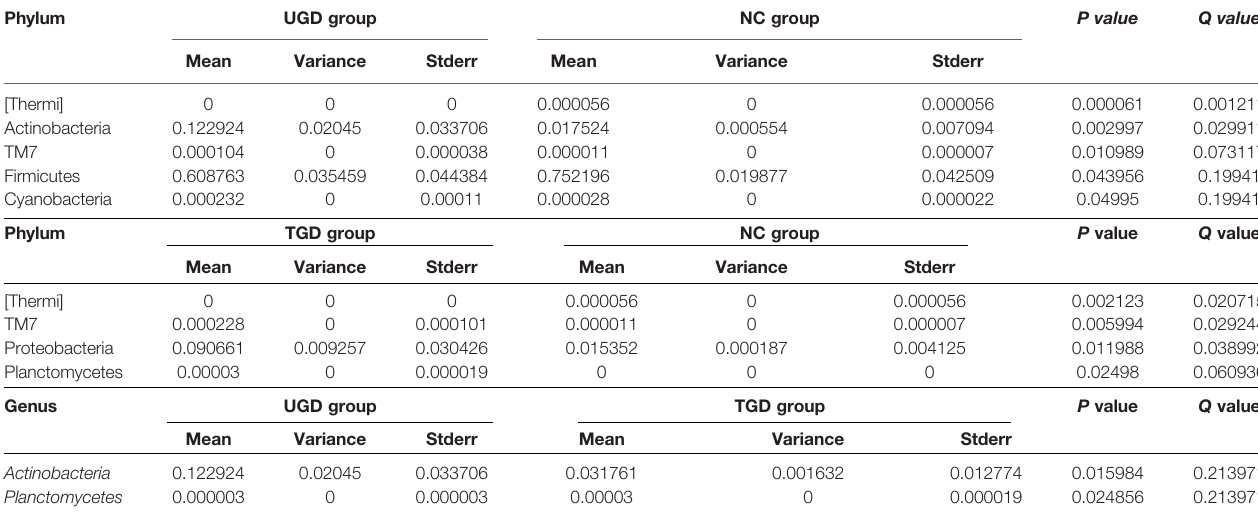
TABLE 4 | Statistical table for the comparison of the Metastats test results among the 3 groups at the phylum level.